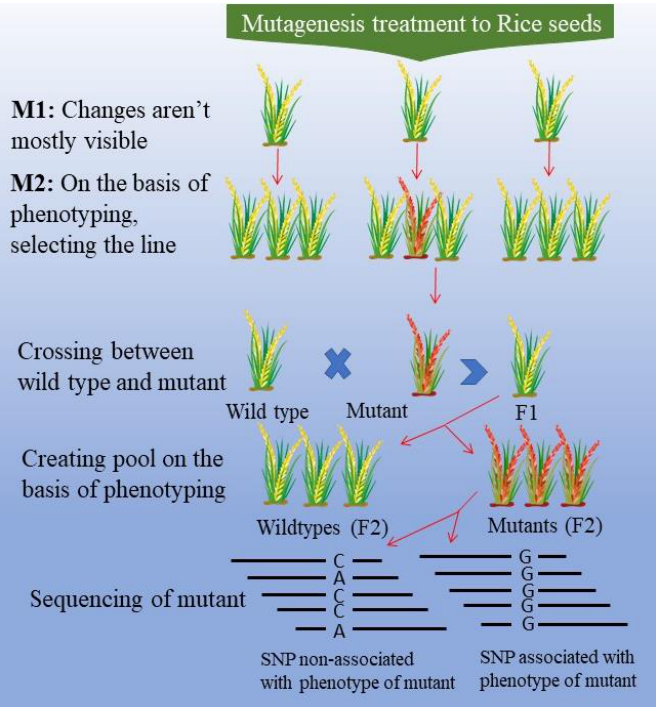
Figure 1. The process of MutMap